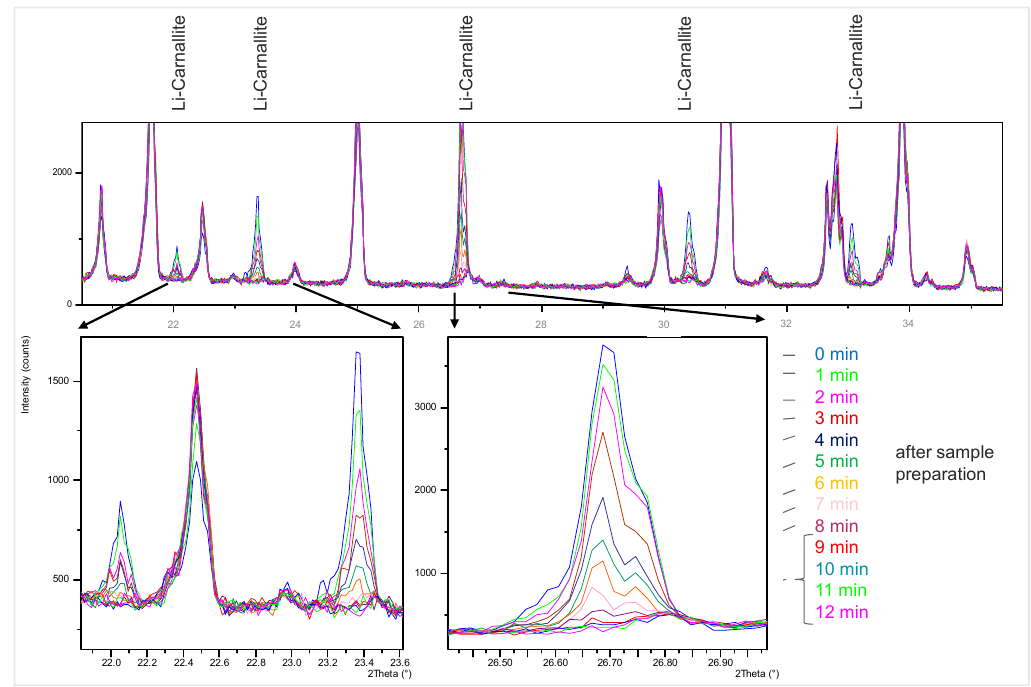
Figure 41. XRD measurement of one brine sample containing lithium carnallite using an open sample holder under ambient conditions, sample measured in 1 min intervals directly after preparation.